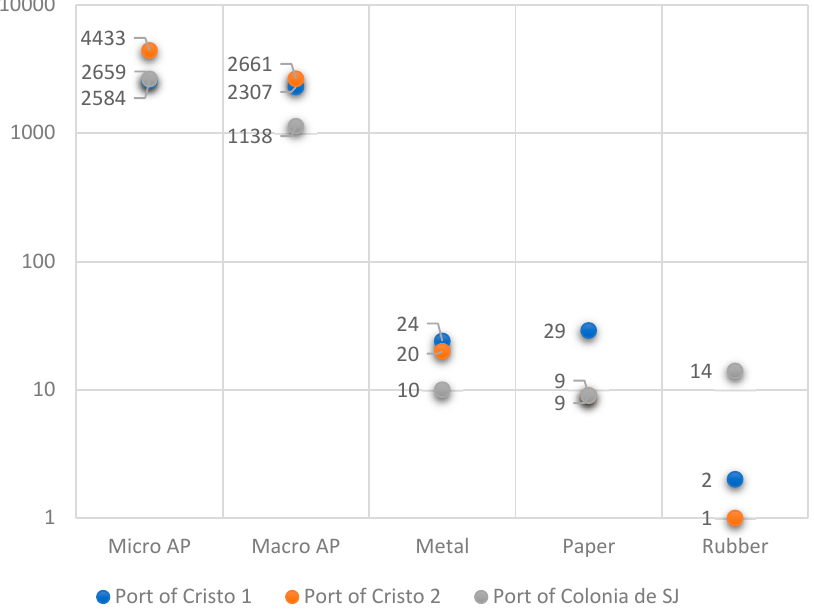
Figure 6. Composition of marine litter by sampling sites (logarithmic scale, base 10). As it can be seen, the predominant category is Micro AP with a total of 9676 collected items (60.86%), followed by Macro AP with a total of 6106 collected items (38.4%). All other categories together are represented in 0.74% (Figure 7).